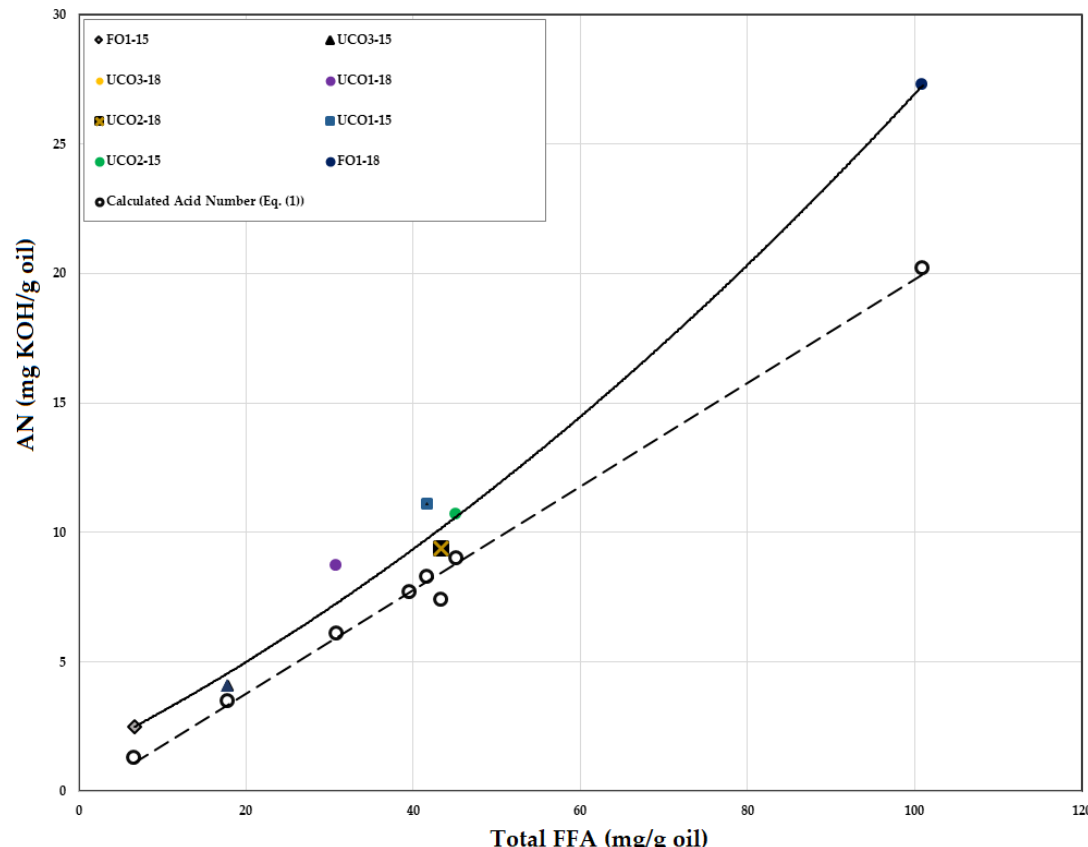
Figure 4. Measured and theoretically calculated acid number (AN) values as functions of the measured total FFA after two and five years’ storage. The solid and dashed lines give the least-square fitting of the experimental and calculated values, respectively.